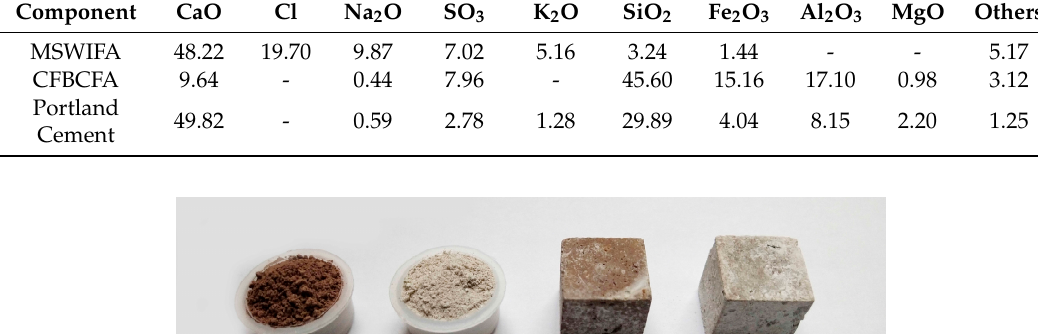
Table 1. Chemical constituents of MSWIFA, CFBCFA, and Portland cement (wt%). Component